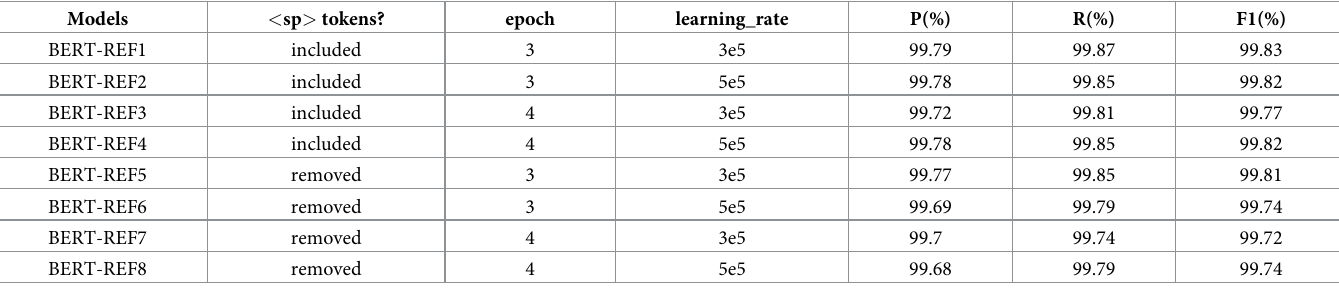
Table 8. Model performances according to hyper-parameters for transfer learning and presence or absence of whitespace tokens in the corpus.